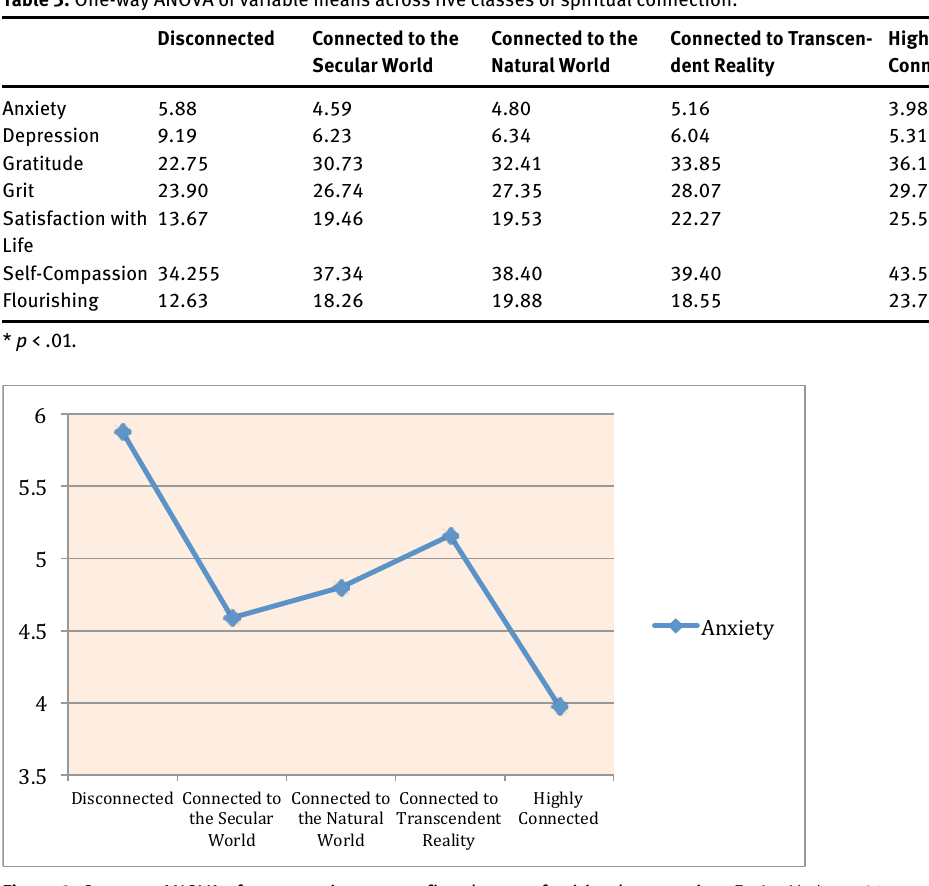
Figure 3. One-way ANOVA of mean anxiety across five classes of spiritual connection, F=6.76*. * p <